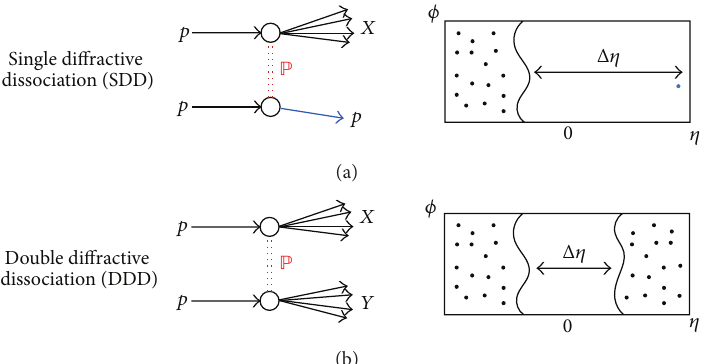
𝑋 and 𝑌 , respectively. In single diffractive dissociation, 𝑀